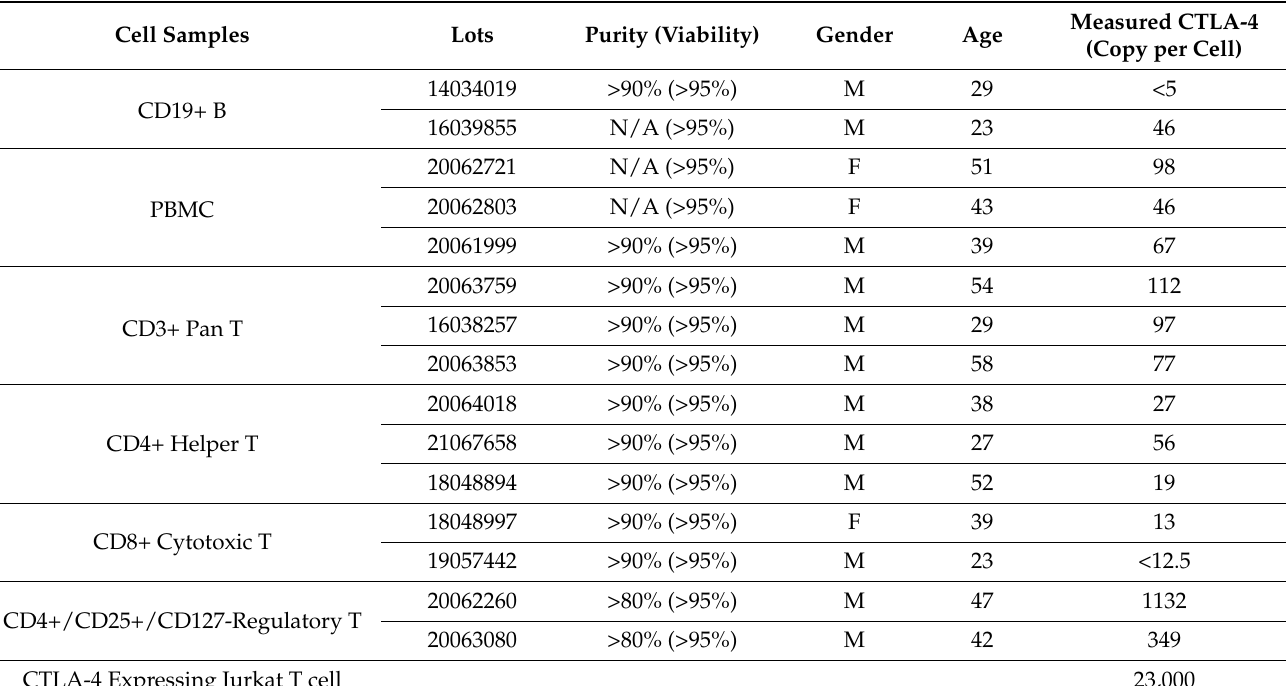
Table 3. Measured Total CTLA-4 Concentration in Human T, B, and Cultured Jurkat Cells. Cell